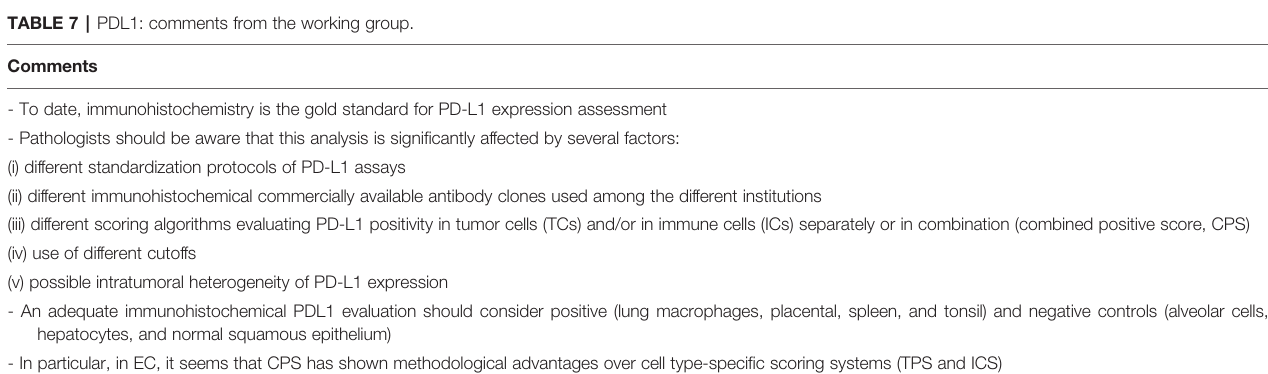
FIGO grade and other clinicopathological factors (17).